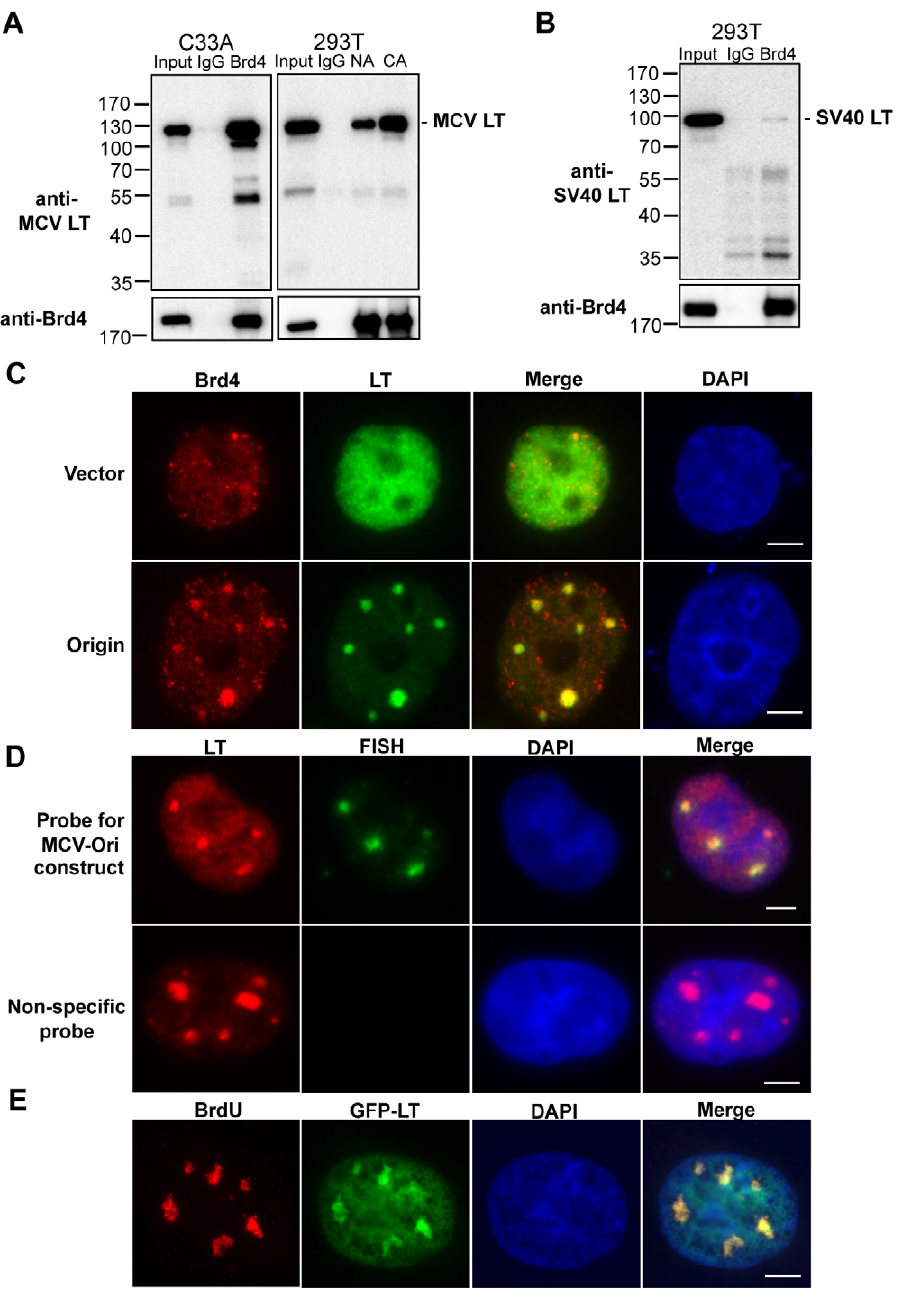
Figure 1. Human Brd4 interacts with MCV LT. A . MCV LT Co-IP with Brd4. C33A cells were transfected with pcDNA4C-MCV LT. Nuclear extracts IPed with normal rabbit IgG (IgG) or the polyclonal Brd4NA antibody (Brd4) were immunoblotted for MCV LT and Brd4. This experiment was repeated three times with similar results. 293T cells were transfected with pADL* (an LT expression plasmid). Nuclear extracts were IPed using normal rabbit IgG (IgG), Brd4 N-terminal antibody (NA) or Brd4 C-terminal antibody (CA). 20% of the Co-IP samples and 20 m g nuclear extracts (input) were immunoblotted for MCV LT and Brd4. B . SV40 LT interacts weakly with human Brd4. 293T nuclear extracts IPed with normal rabbit IgG (IgG) or Brd4CA antibody (Brd4) were immunoblotted for SV40 LT and Brd4. C . Co-localization of Brd4 and MCV LT. C33A cells were co-transfected with pcDNA4C-MCV LT and either pcDNA4C-MCV Ori (Origin) or pcDNA4C (Vector). Cells were double-stained with Brd4 CA (Red) and MCV LT antibody (Green). Cells were also counter-stained with DAPI. Bar, 5 m m. D . MCV Ori DNA is detected in the MCV LT foci. C33A cells were co-transfected with pADL* and pcDNA4C-MCV Ori. A specific probe recognizing pcDNA4C-MCV Ori and a non-specific probe recognizing the HPV genome were used in Immuno-FISH analysis. Cells were stained with MCV LT antibody (Red) and DNA probes were stained with fluorescein avidin DN (Green). Bar, 5 m m. E . C33A cells were co-transfected with pcDNA4C-MCV LT, pEGFP-MCV LT and pcDNA4C-MCV Ori. pEGFP-MCV LT was used to mark the MCV LT localization. Cells were pulsed with 10 m M BrdU for 20 min and stained with anti-BrdU antibody (Red). Cells were also counter-stained with DAPI. Bar, 5 m m. All experiments have been repeated more than 3 times with similar results.